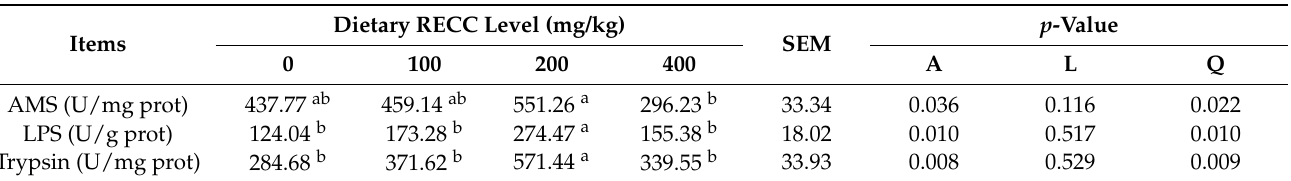
Table 6. Effects of dietary rare earth chitosan chelates (RECC) on duodenal digestive enzyme activity of laying